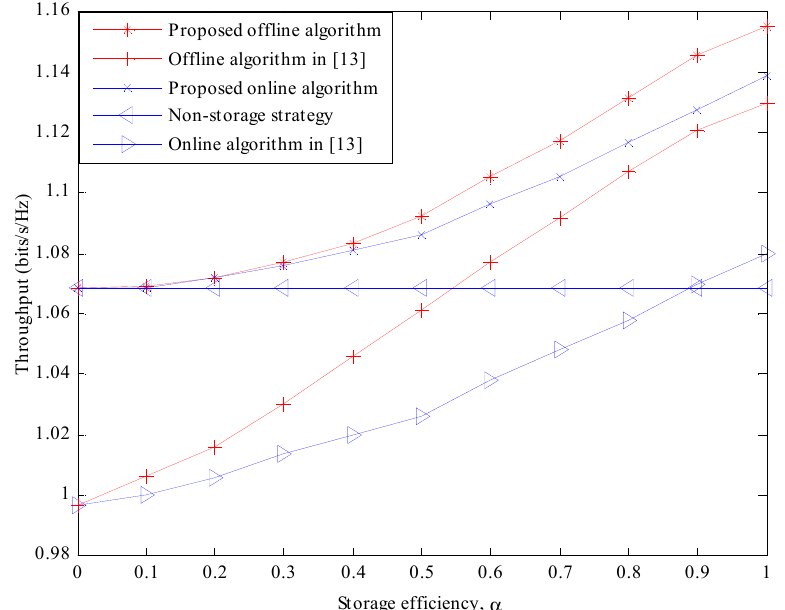
Figure 4. Throughput for the time-varying channel with energy arrivals obeying the uniform distribution of [5, 15] mJ.